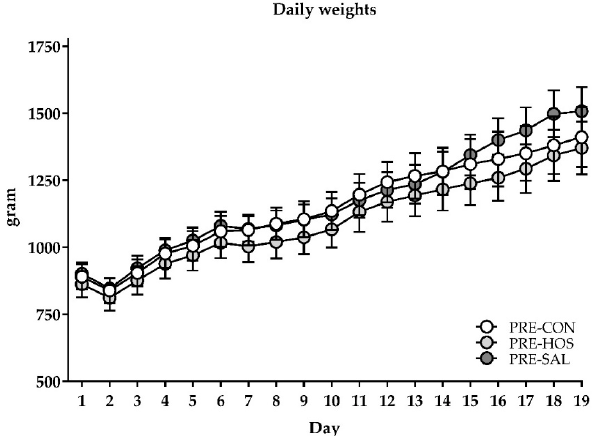
Figure 1. Growth curves in preterm pigs (Experiment 1). Daily weights of preterm pigs with or without oligosaccharide supplementations. No differences were observed between PRE-CON (white) and the supplemented groups, PRE-HOS (light grey) and PRE-SAL (dark grey). Values are presented as mean ± standard error of the mean (SEM).